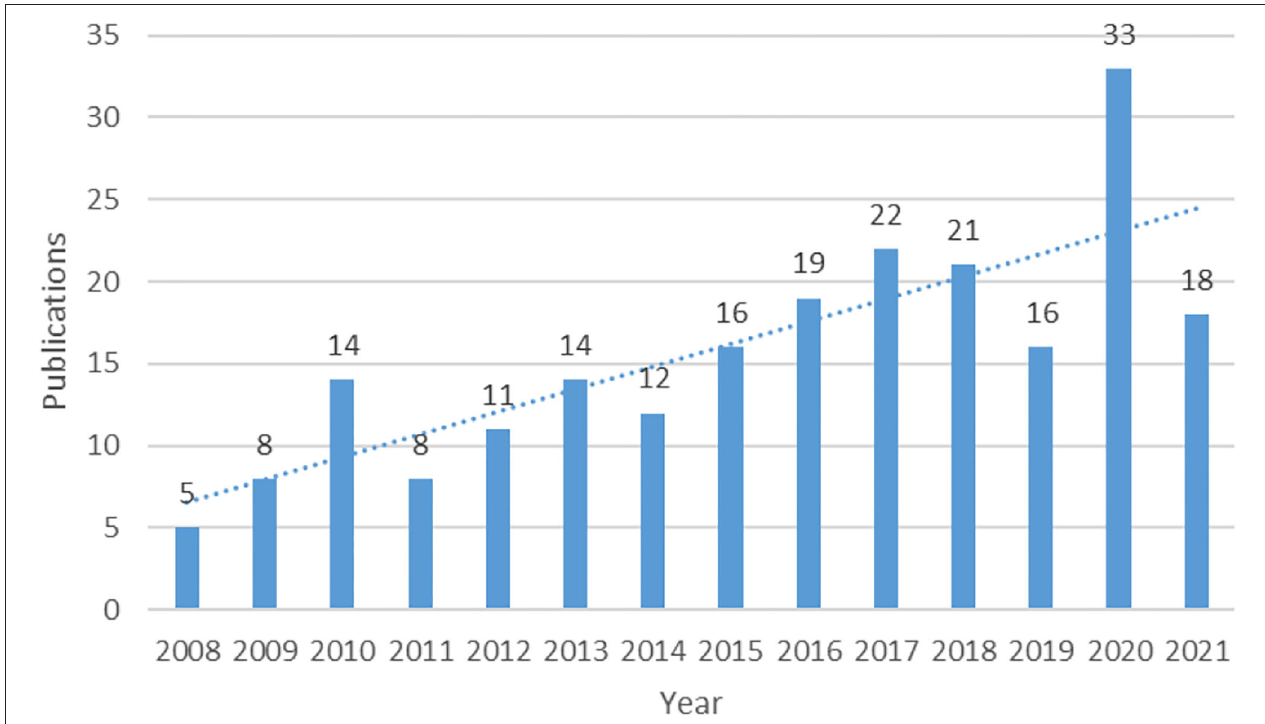
FIGURE 2 | The number of annual publications on acupuncture treatment for Parkinson’s disease (PD) from 2000 to 2021. The horizontal coordinate represents the different years and the vertical coordinate represents the single-year publication number.